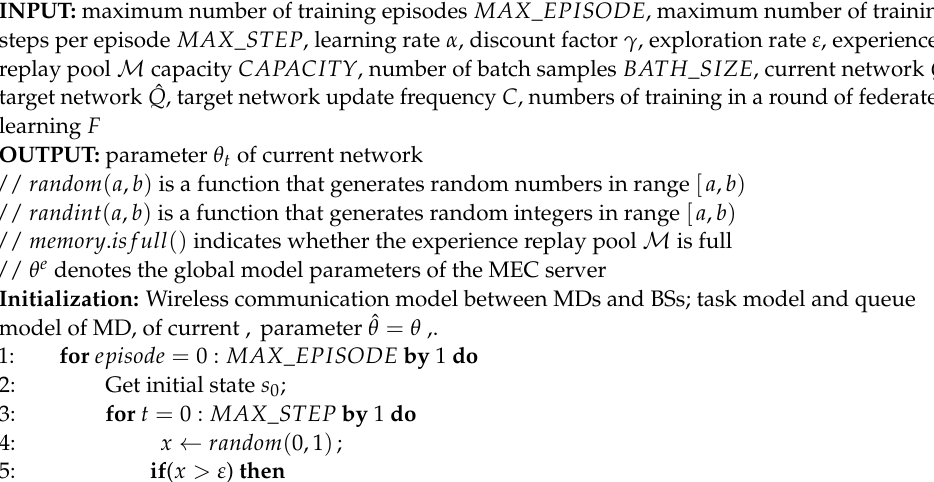
Algorithm 1 FDRT’s Mobile Device Agent